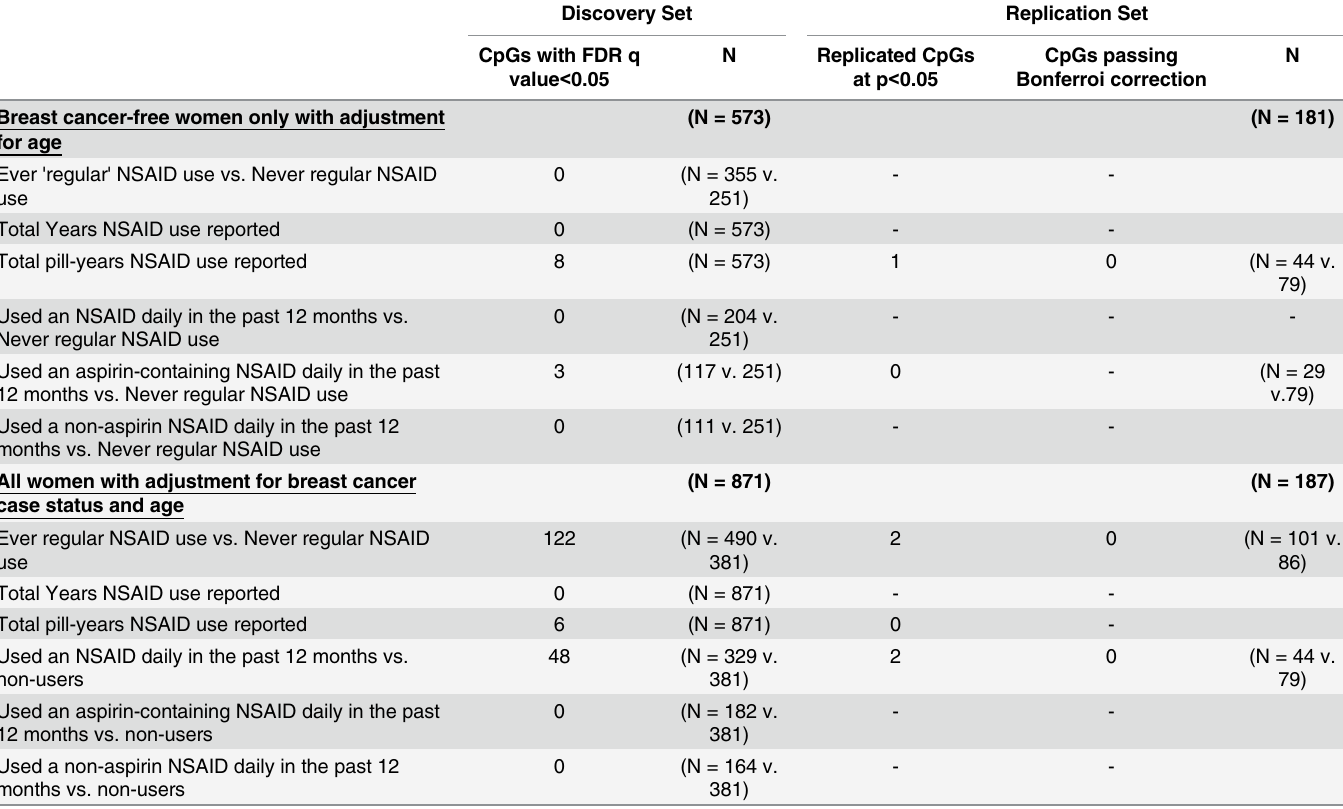
Table 2. Differential methylation of CpG sites by NSAID use in the discovery and replication